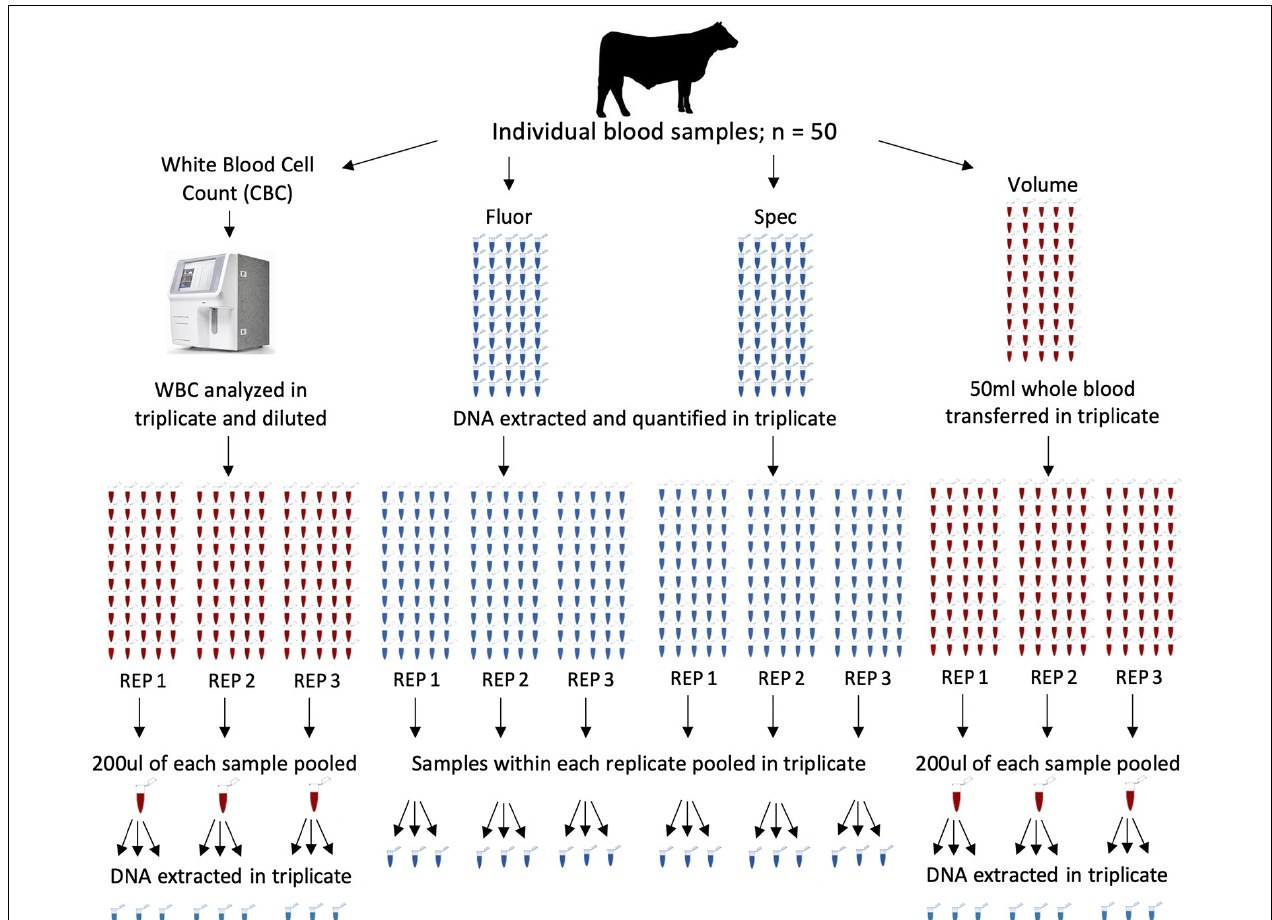
FIGURE 1 | Pool construction for four different methods, each with fifty individuals represented in each pool. Samples from each method were pooled and extracted in triplicate for a total of 36 pools. The four methods of pooling were based on equal amounts of white blood cell counts (CBC), DNA concentrations determined by spectrofluorometer (Fluor), DNA concentrations determined by spectrophotometer (Spec), and whole blood based on volume (Volume). Each main column represents a method of pooling. Columns of tubes within a method represent samples going into each pool. Red tubes are blood and blue tube are extracted DNA. Pools were constructed with all 50 individuals represented in each pool. Pools were constructed in triplicate and DNA was extracted from each pool in triplicate.